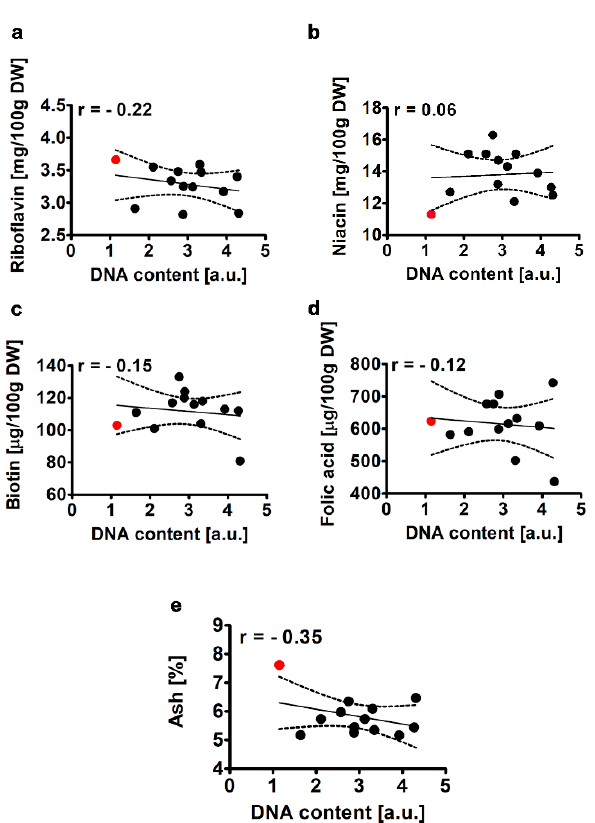
Figure 6. Colchicine and cytochalasin B-mediated e ff ect on the levels of riboflavin ( a ), niacin ( b ), biotin ( c ), folic acid ( d ) and ash ( e ) in the microalga Planktochlorella nurekis . Correlation analysis between riboflavin ( a ), niacin ( b ), biotin ( c ), folic acid ( d ) and ash ( e ) and DNA content. Twelve CC-treated clones were considered (black dots). WT cells are denoted as a red dot. Results represent the mean from three independent experiments. The levels of vitamins were calculated per 100 g of dry weight. The 95% confidence interval is shown. Correlation analysis of the data was performed using a Linear Correlation (Pearson r) test. DW, dry weight.